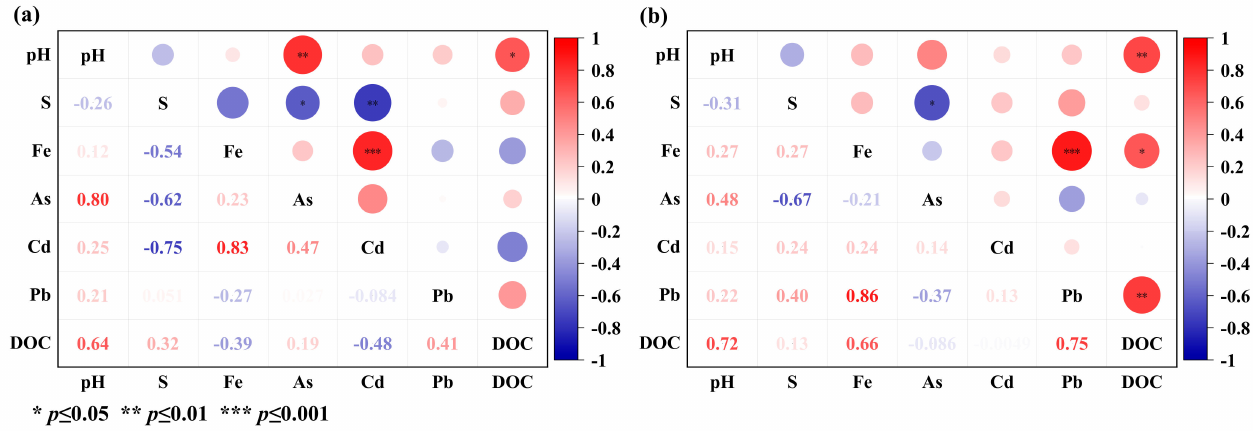
Figure 4. Correlation between physical and chemical properties of soil and bioavailability of Cd, Pb, and As in the horizontal soil column. ( a ): CK; ( b ): CSF.